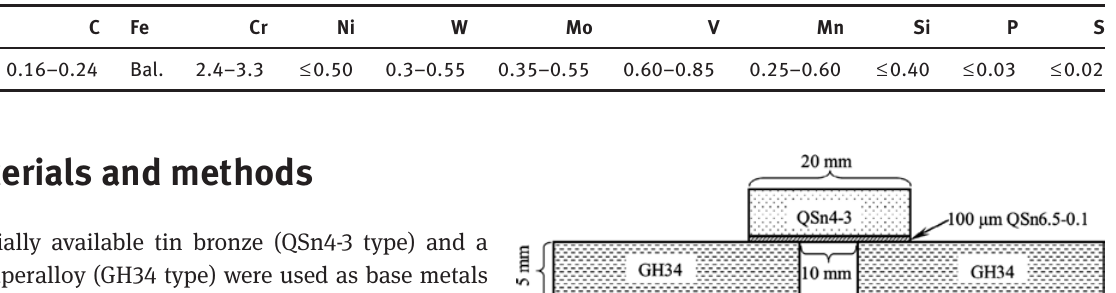
Table 1 Chemical composition of GH34 (wt.%).